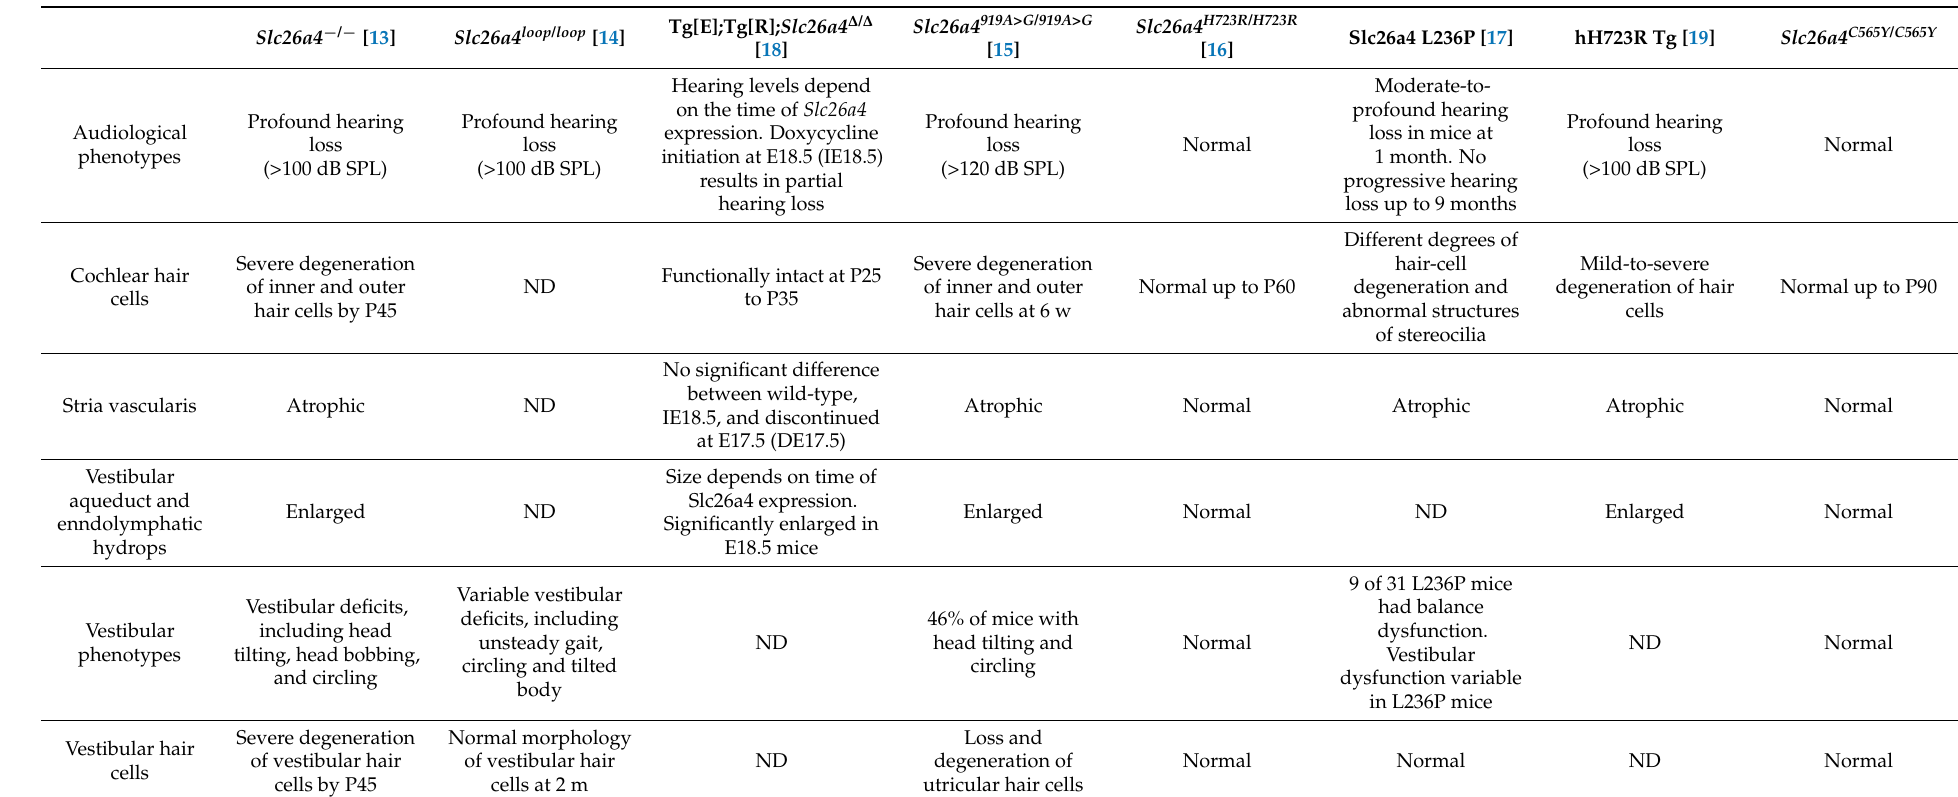
Table 1. Comparison of phenotypes among mouse strains with different Slc26a4